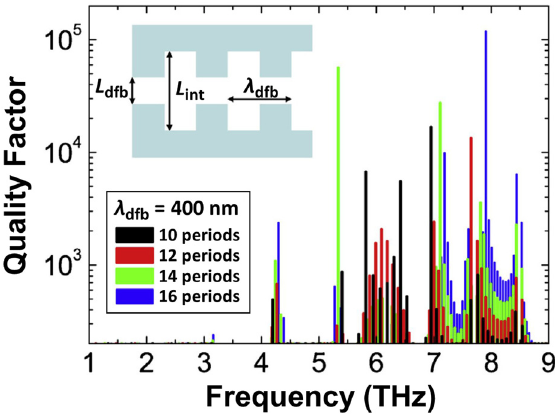
Figure 3: Numerically simulated frequency spectral dependencies of the quality factors for different number of periods. The inset shows the top view of a plasmonic DFB cavity structure with key design parameters of λ dfb = 400 nm, L dfb = 200 nm, and L int = 500 nm. Adapted with permission from ref. [41]. Copyright 2021, Association of Polish Electrical Engineers (SEP), published by Elsevier